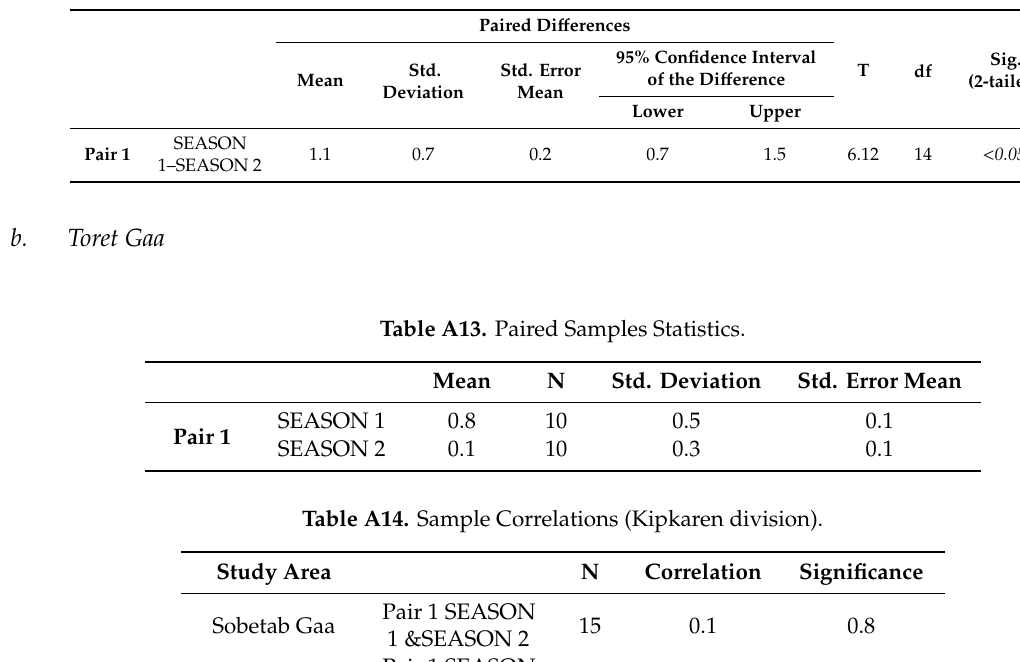
Table A12. Paired Samples Test.